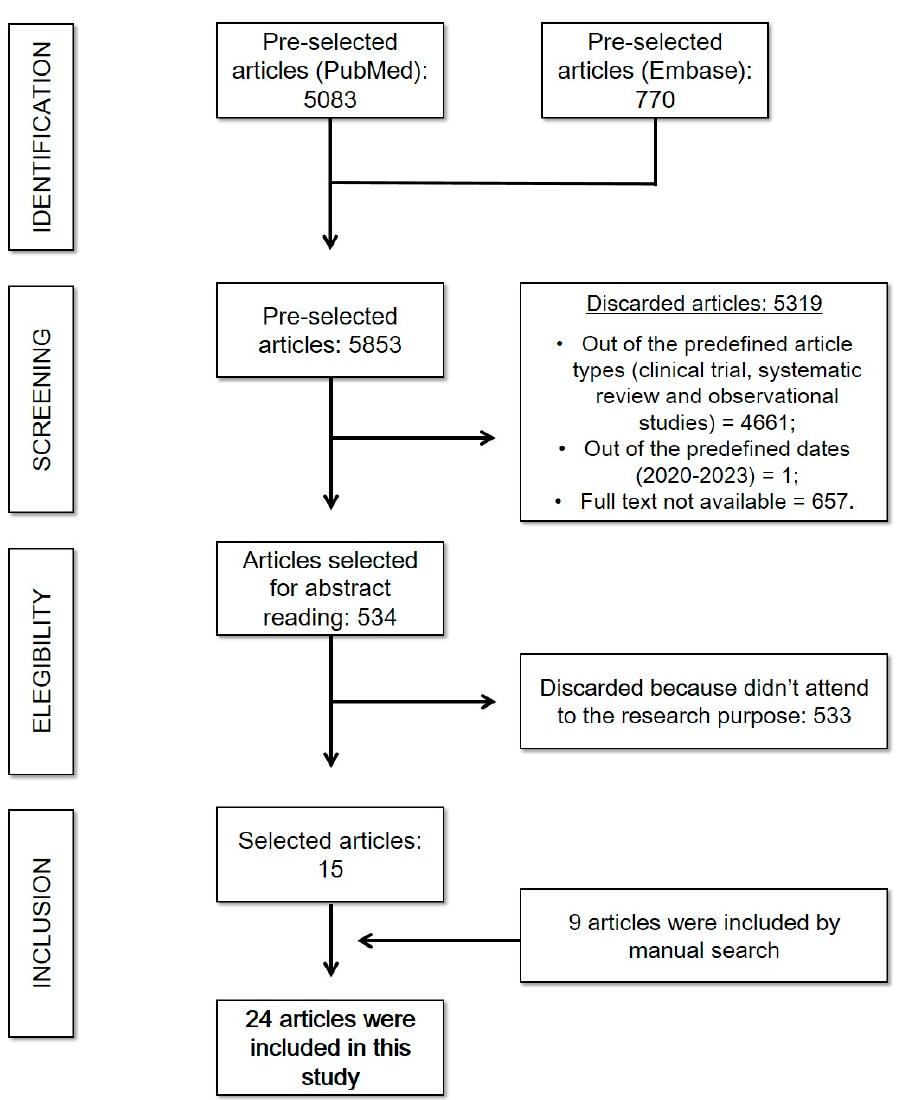
Scheme 2. Cardiovascular complications of COVID-19: search strategy. (Reference: elaborated by the